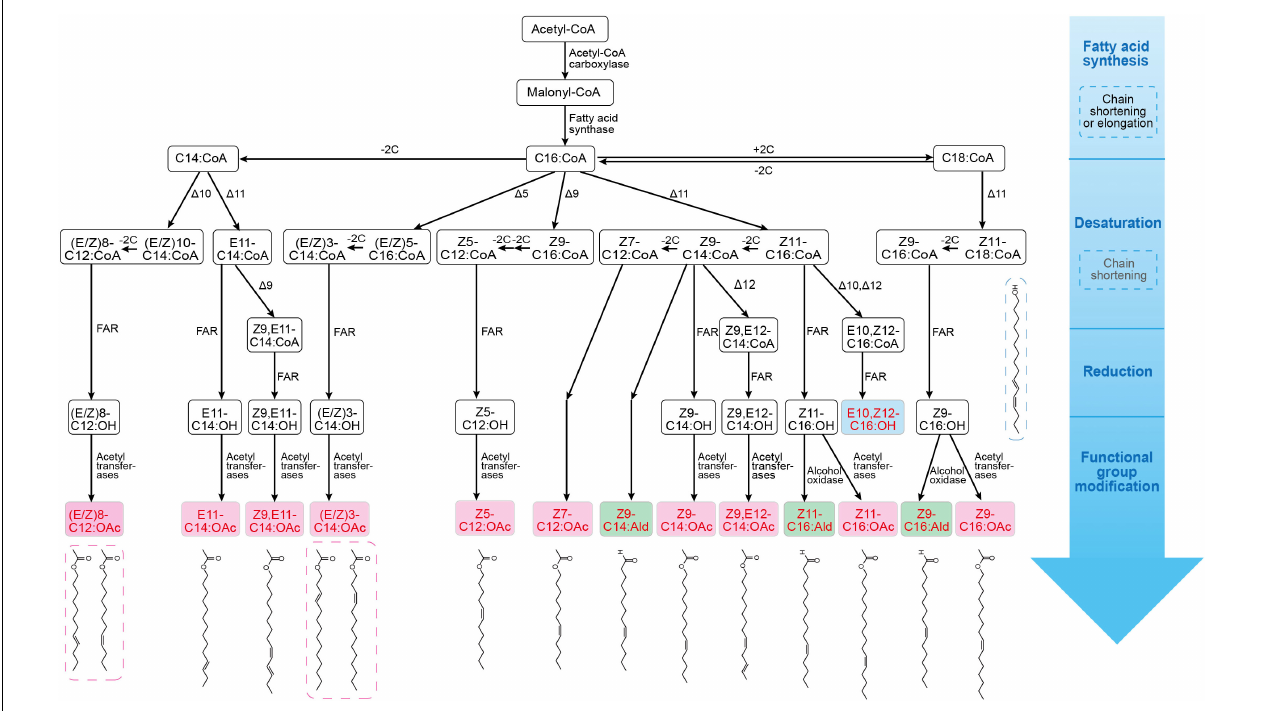
FIGURE 1 | Biosynthetic pathways of sex pheromones in several lepidopteran species (including Bombyx mori , Spodoptera litura , Streltzoviella insularis , Antheraea pernyi , Thysanoplusia intermixta , Heliothis subflexa , H. virescens , Grapholita molesta , and G. dimorpha ). Pheromone synthesis starts with a ubiquitous fatty acid synthesis, followed by desaturation of fatty acyl-CoA precursors, then reduction and functional group modification steps to produce species-specific alcohol (blue), aldehyde (green), or acetate ester (pink), that can be used as pheromone blends; the structure of each pheromone molecule is also shown. The general biosynthesis processes and enzymes involved are also marked in this